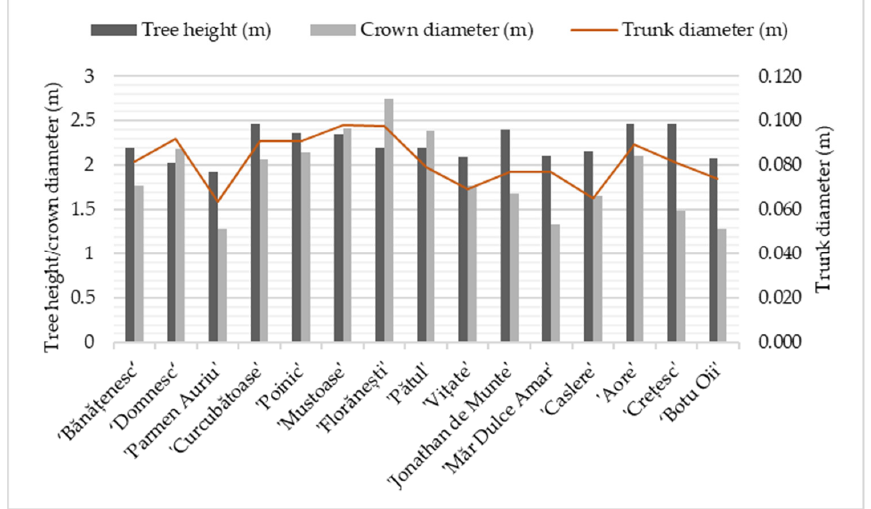
Figure 2. Growth vigor of the investigated grafted apple varieties. The values determined for the analyzed parameters (large diameter, fruit mass, sugar content and acidity), both for the original biological material and after grafting of the 15 investigated apple varieties, are presented in Tables 4 and 5, as means ± standard deviation (SD). Between the variants with the same letters, there are significant differ- ences at a confidence level of 95% (α = 0.05). Table 4. The characteristics of the apple varieties before grafting. Variety